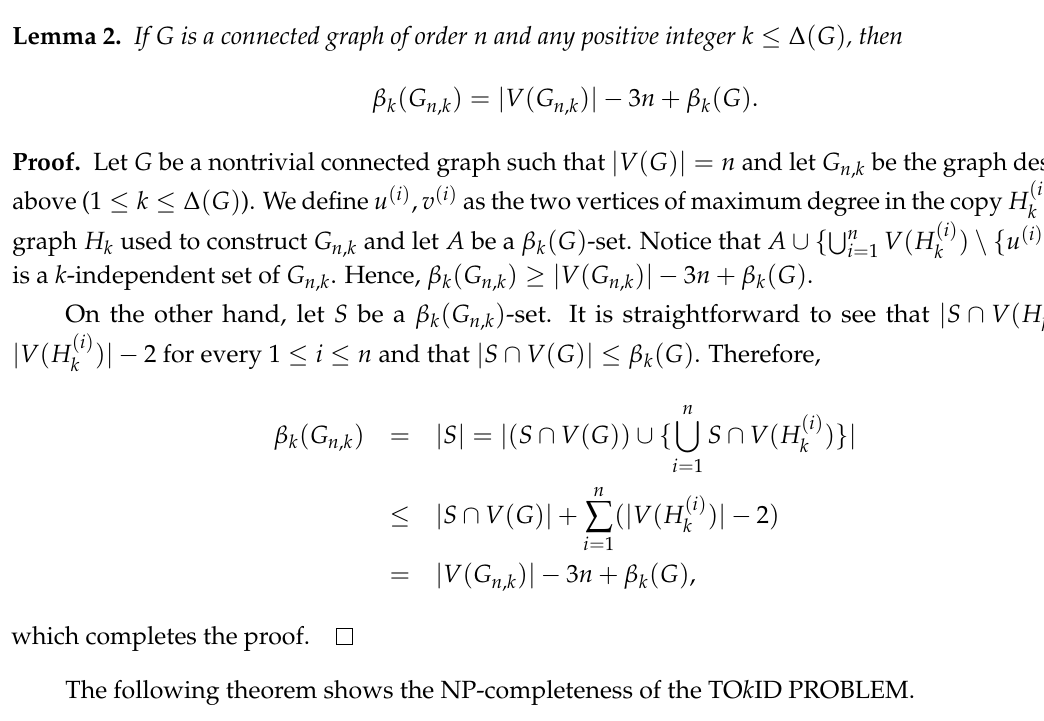
Figure 2. The graph H 2 ( I ) and a graph G 4,2 ( II ) where G is a complete graph minus one